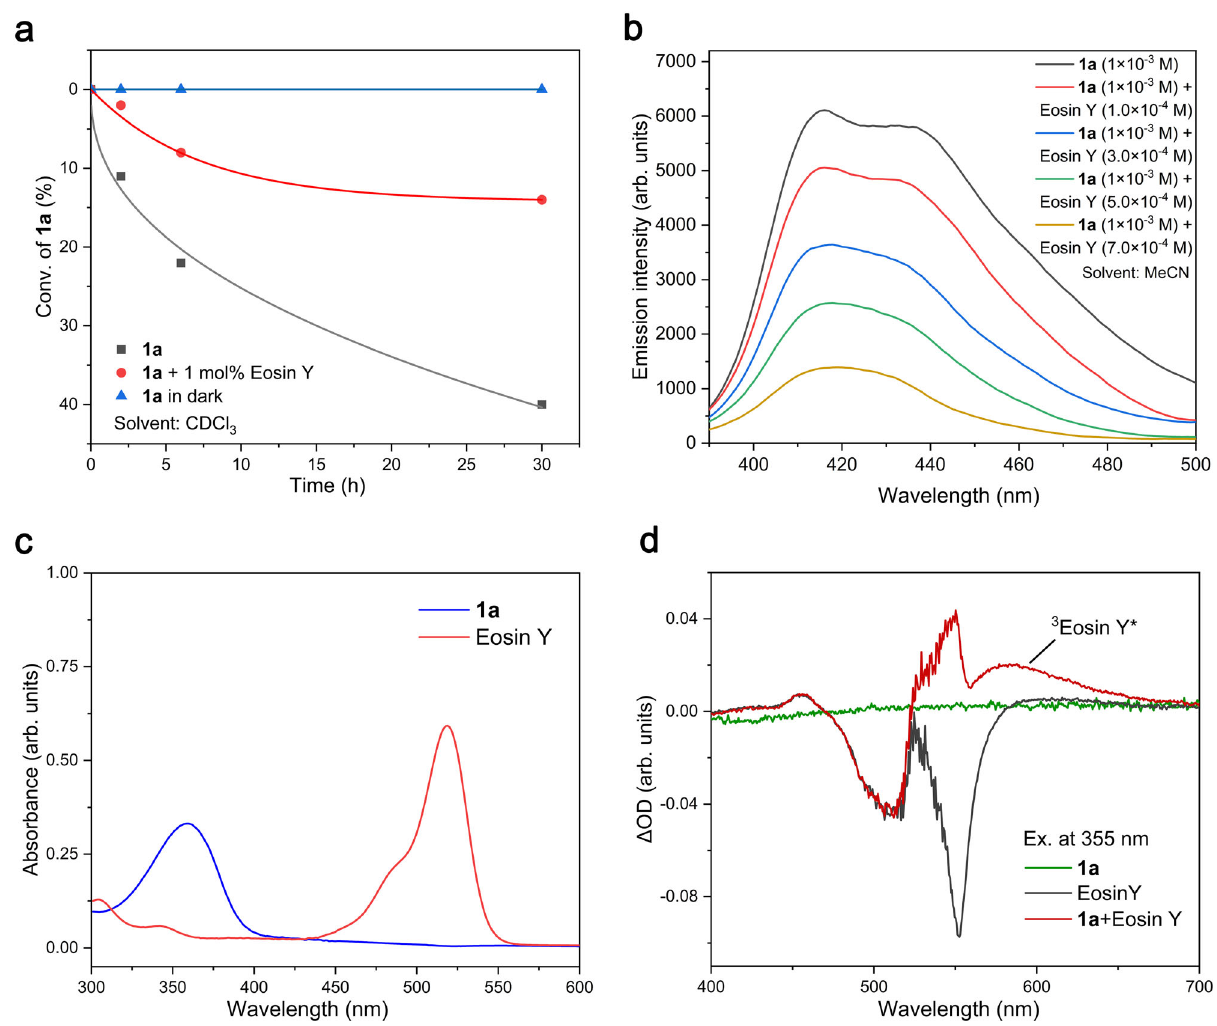
Fig. 2 | Proof of concept: inhibition of visible-light-induced decomposition of acylsilanes via energy transfer catalysis. a Light-induced decomposition of 1a . b Luminescence quenching experiments. c UV/Vis of 1a and Eosin Y. d Transient